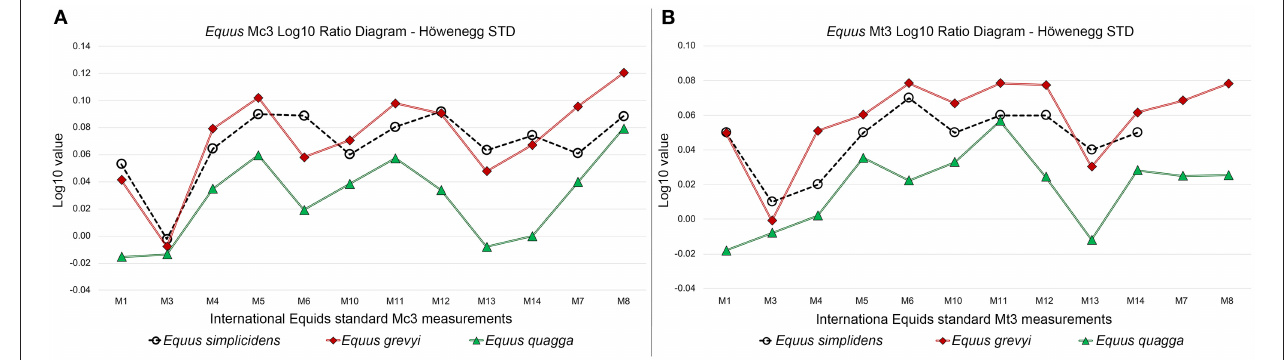
Frontiers in Ecology and Evolution |